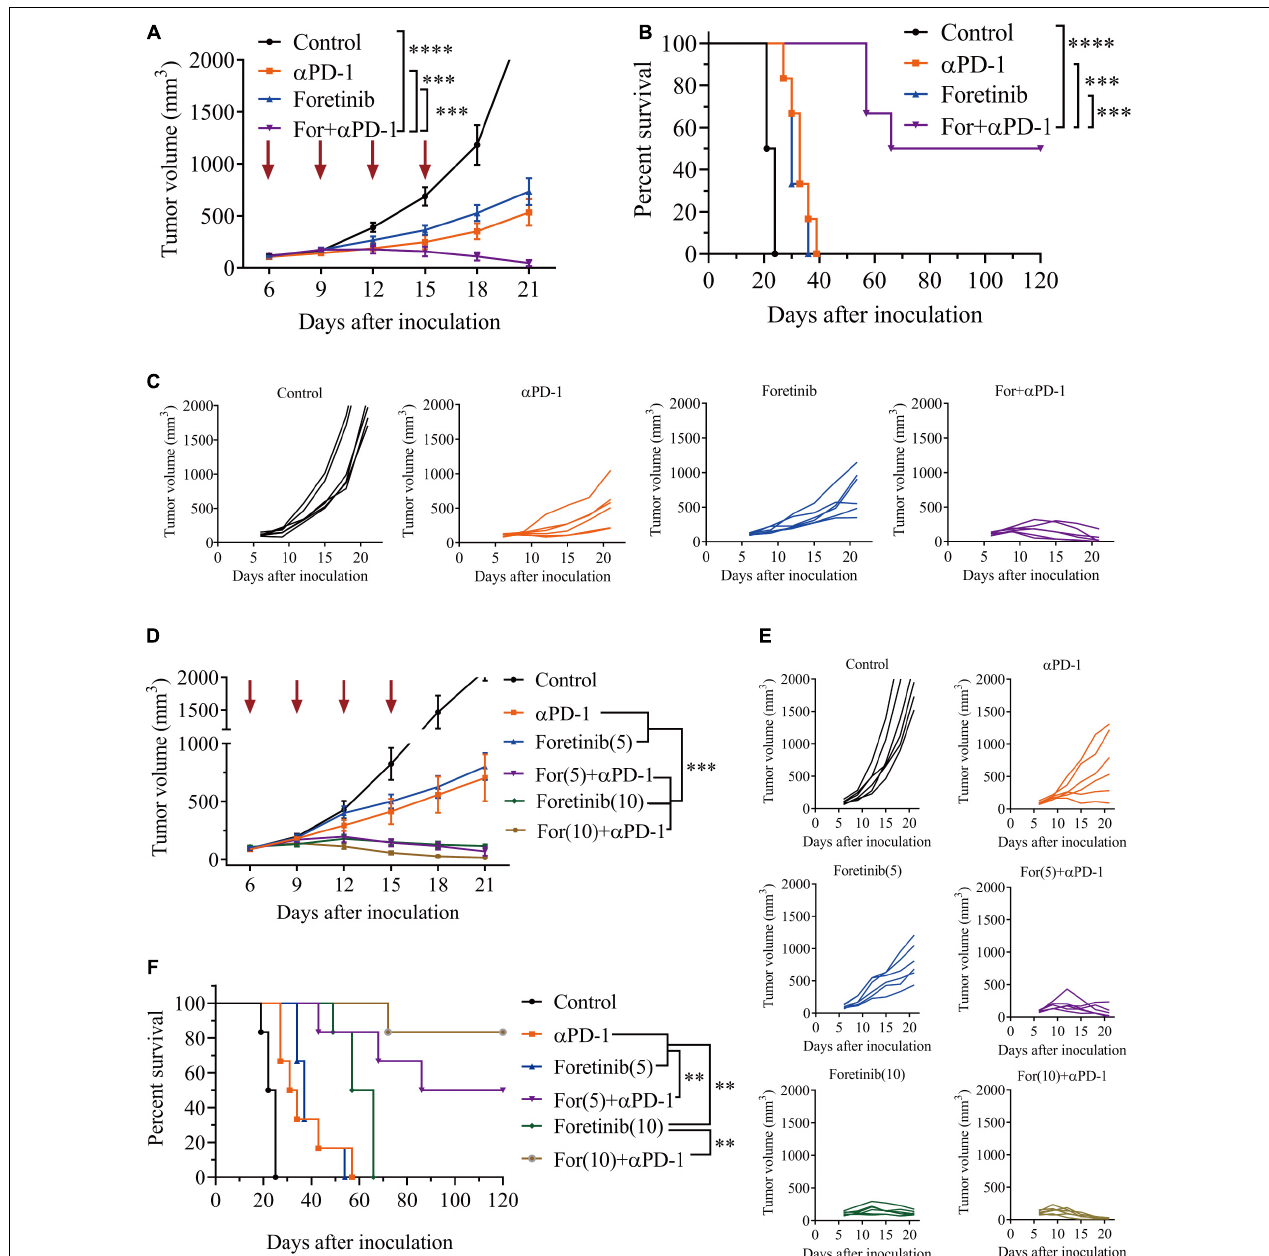
FIGURE 2 | Foretinib synergistically enhanced the anti-tumor function of the α PD-1 antibody in vivo . MC38 cells subcutaneously implanted into the mice and when the volume reached approximately 100 mm 3 , the mice were randomly allocated to either the control or treatment groups ( n = 6). The drugs were given as described in the “Materials and Methods” section. (A) The tumor volume was measured every 3 days. (B) The Kaplan–Meier survival distribution in the model is displayed for the mice following the treatment protocol. (C) Tumor growth curves for the mouse in each group are displayed. (D–F) The tumor volume and survival data were shown for mice with MC38 tumors that received the increased Foretinib dose (10 mg/kg). The data is presented using the mean ± SEM where applicable, * ( P ≤ 0.05), ** ( P ≤ 0.01), *** ( P < 0.001), **** ( P < 0.0001), and ns (no statistical significance, P ≥ 0.05).